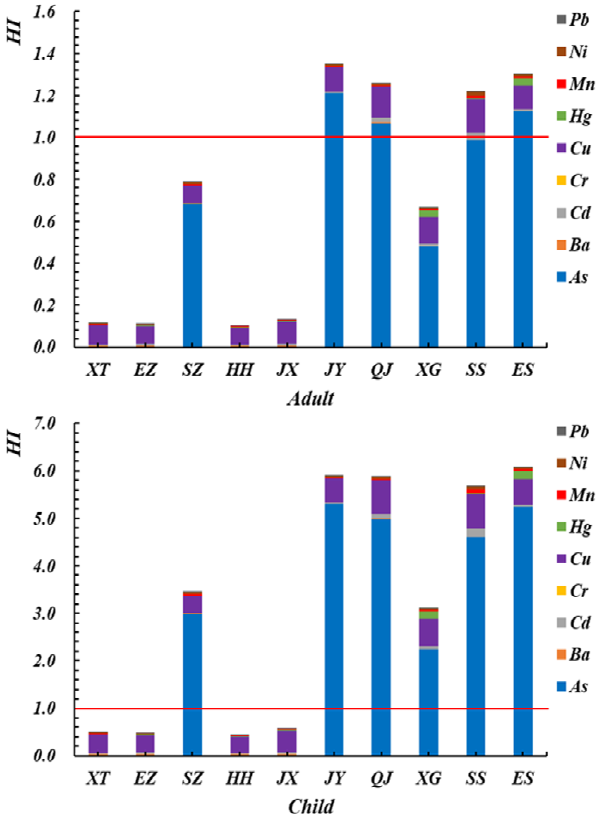
Figure 7. Average HI values of nine heavy metals in crayfish from different